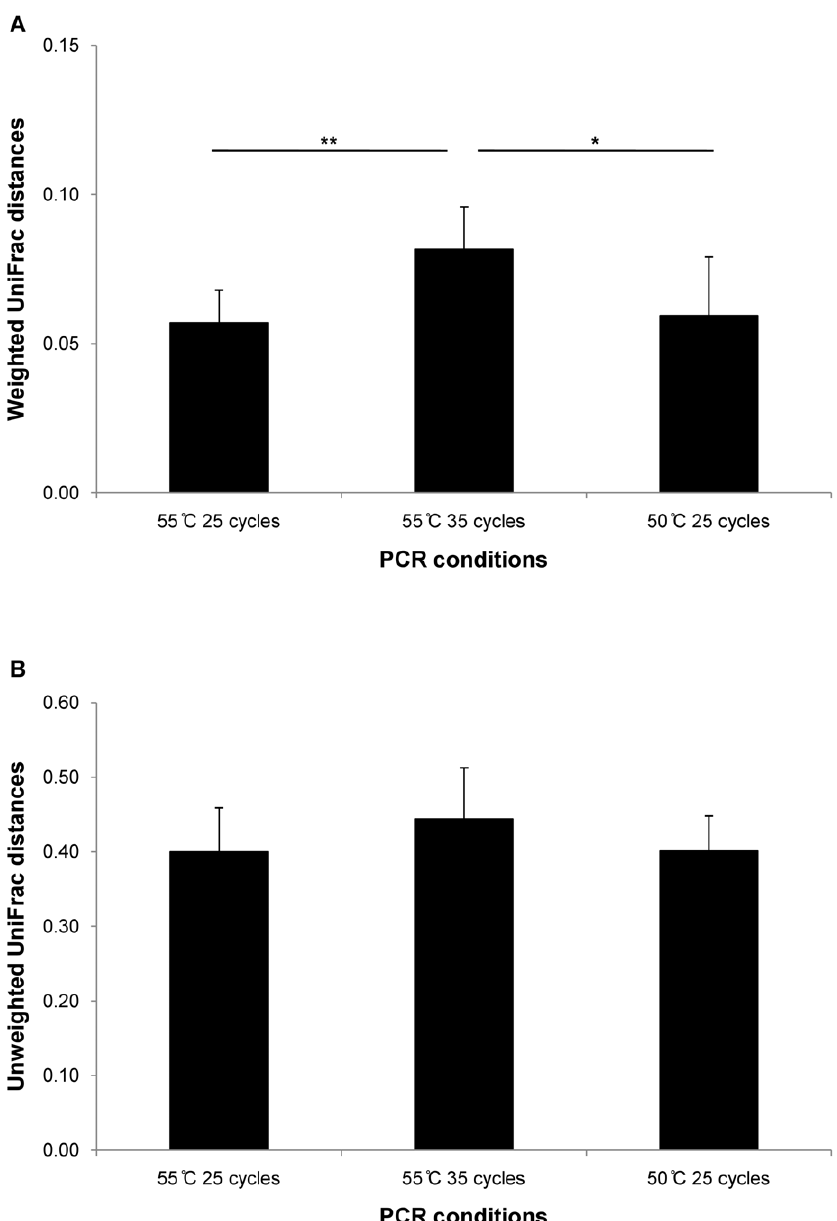
Figure 4. UniFrac distances between different PCR conditions. (A) Weighted and (B) unweighted UniFrac distances. UniFrac distances were calculated between the most used PCR condition (annealing temperature: 55 u C and the number of cycle: 25 cycles) and three PCR conditions; the same PCR condition (technical replication), the PCR condition of more cycles (55 u C and 35 cycles), and the PCR condition of lower annealing temperature (50 u C and 25 cycles). * p , 0.05, ** p , 0.01